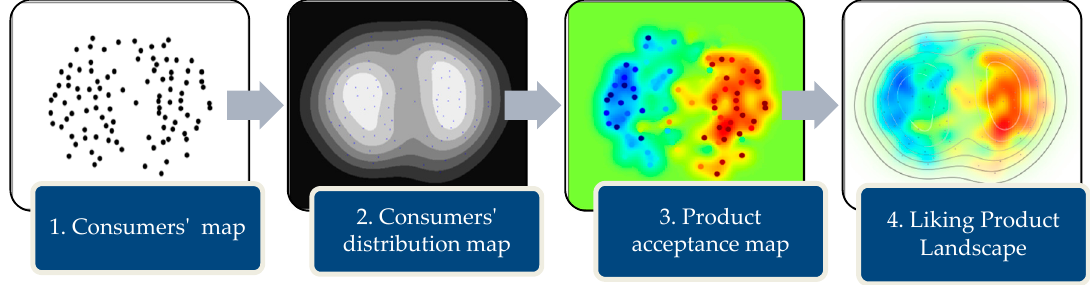
Figure 1. Liking product landscape creation process.